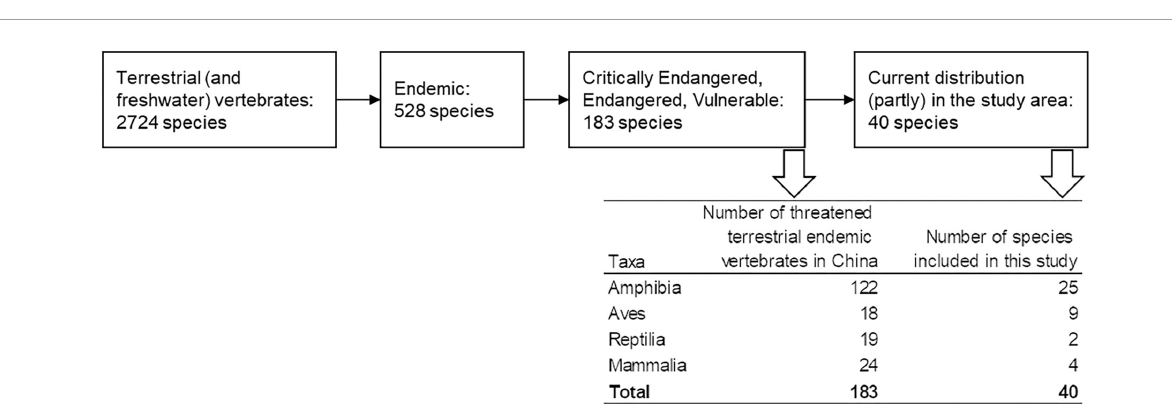
Frontiers in Ecology and Evolution